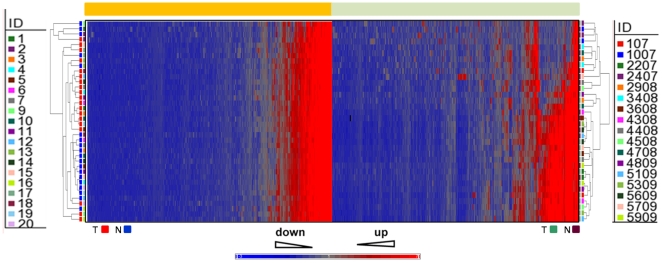
Hierarchical clustering of miRNA expression.miRNA profiles of 36 paired tissue specimens from 19 colorectal cancer (orange box) and 17 pancreatic cancer (green box) patients were clustered. The 36 paired specimens are in rows (coloured bars) and the 866 miRNAs are in columns. T, tumor tissue; N, adjacent normal tissue.